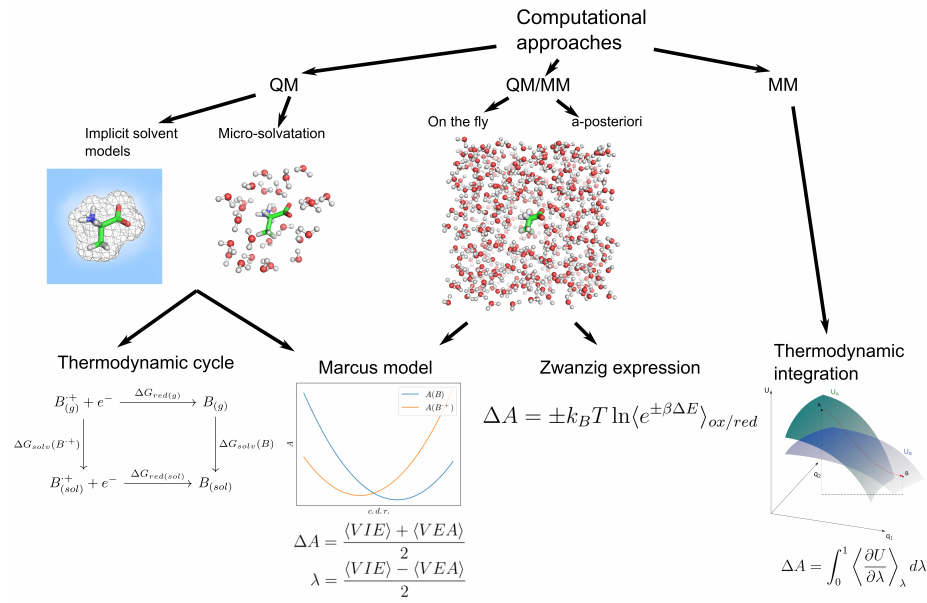
Figure 1. Synthetic scheme of available computational